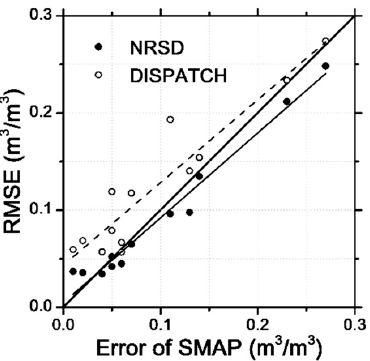
Figure 13. Error analysis by distinguishing downscaling error from SMAP error. The bold diagonal line represents the 1:1 line; the other solid line represents the linear fit of the NRSD error with respect to the SMAP error; and the dashed line represents the linear fit of the DISPATCH error with respect to the SMAP error.